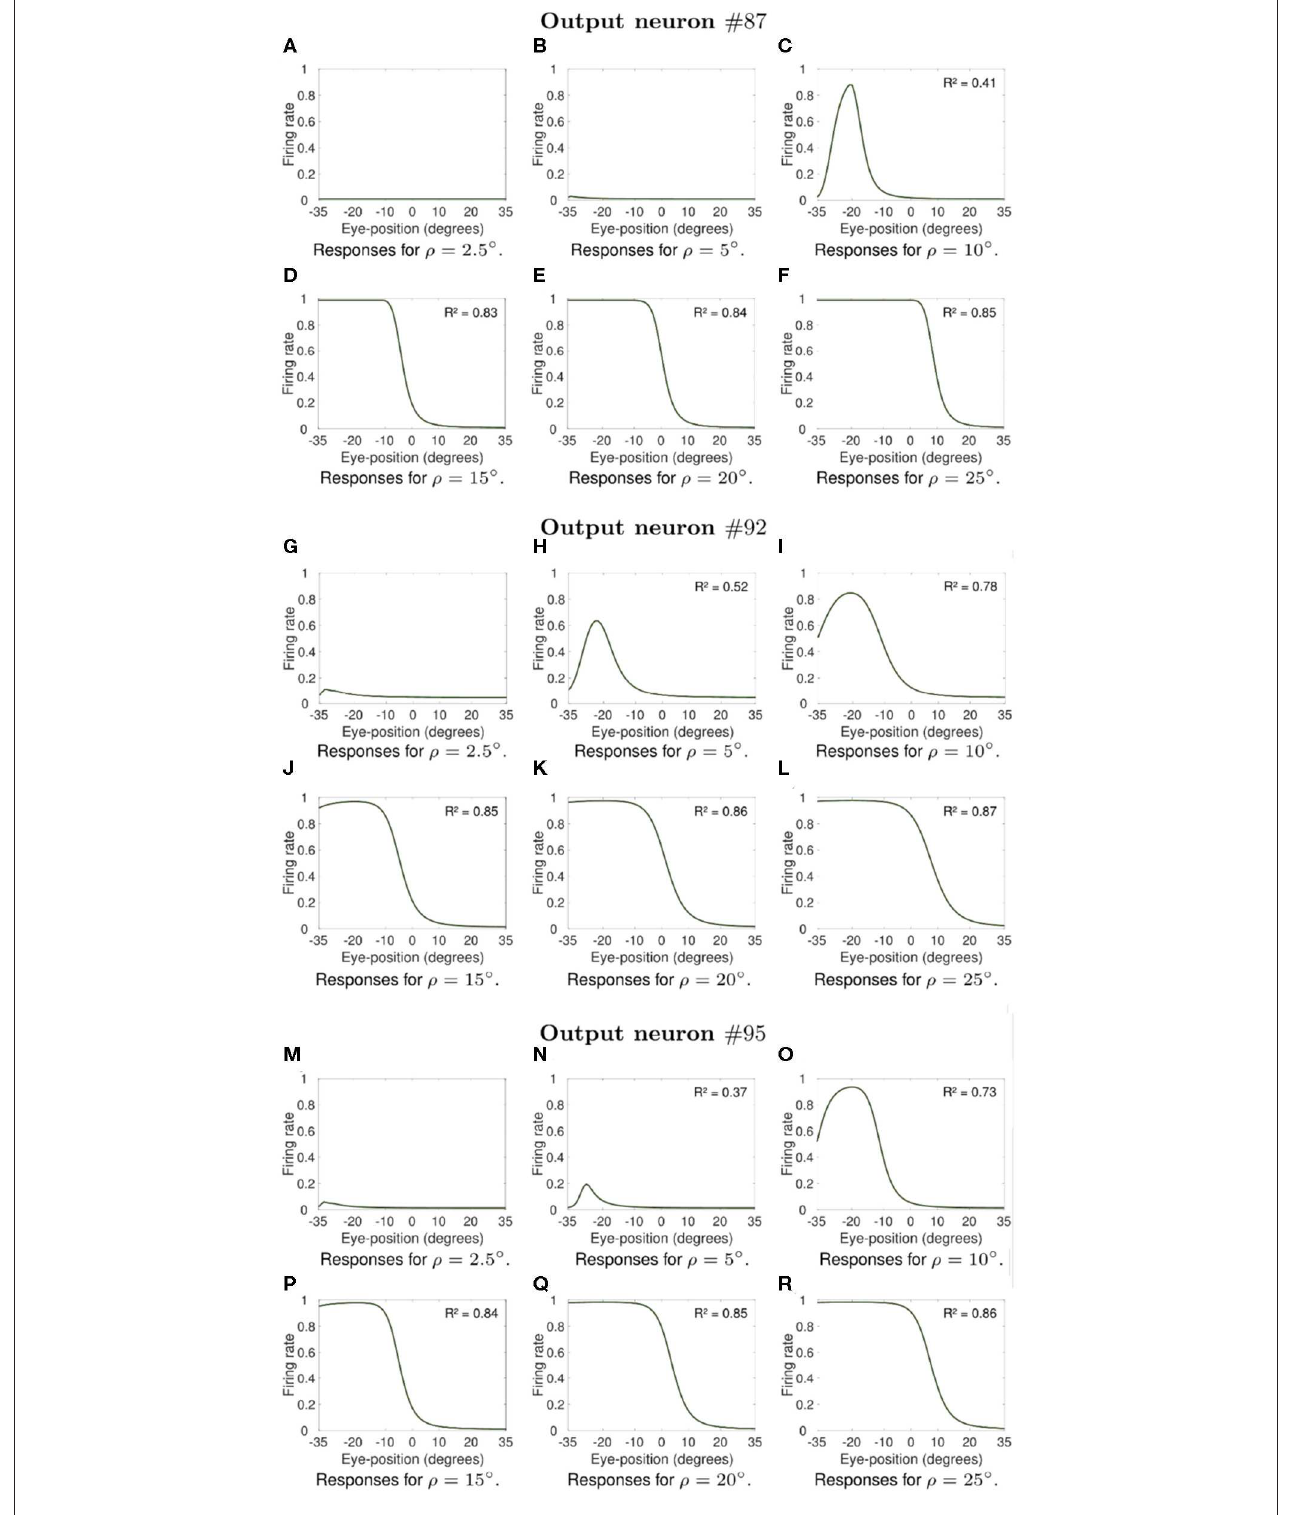
FIGURE 7 | Influence of varying the width ρ of the eye position tuning curve in the self-organizing model. The subplots show how the width ρ of the eye position tuning curve affected the self-organization of the visual responses of neuron # 87, neuron # 92 and neuron # 95. Each subplot shows the responses of these output neurons in the trained model when the visual stimulus was presented at retinal location − 10 ◦ and the eyes shifted from [ − 35 ◦ ,35 ◦ ] in integer steps of one degree.